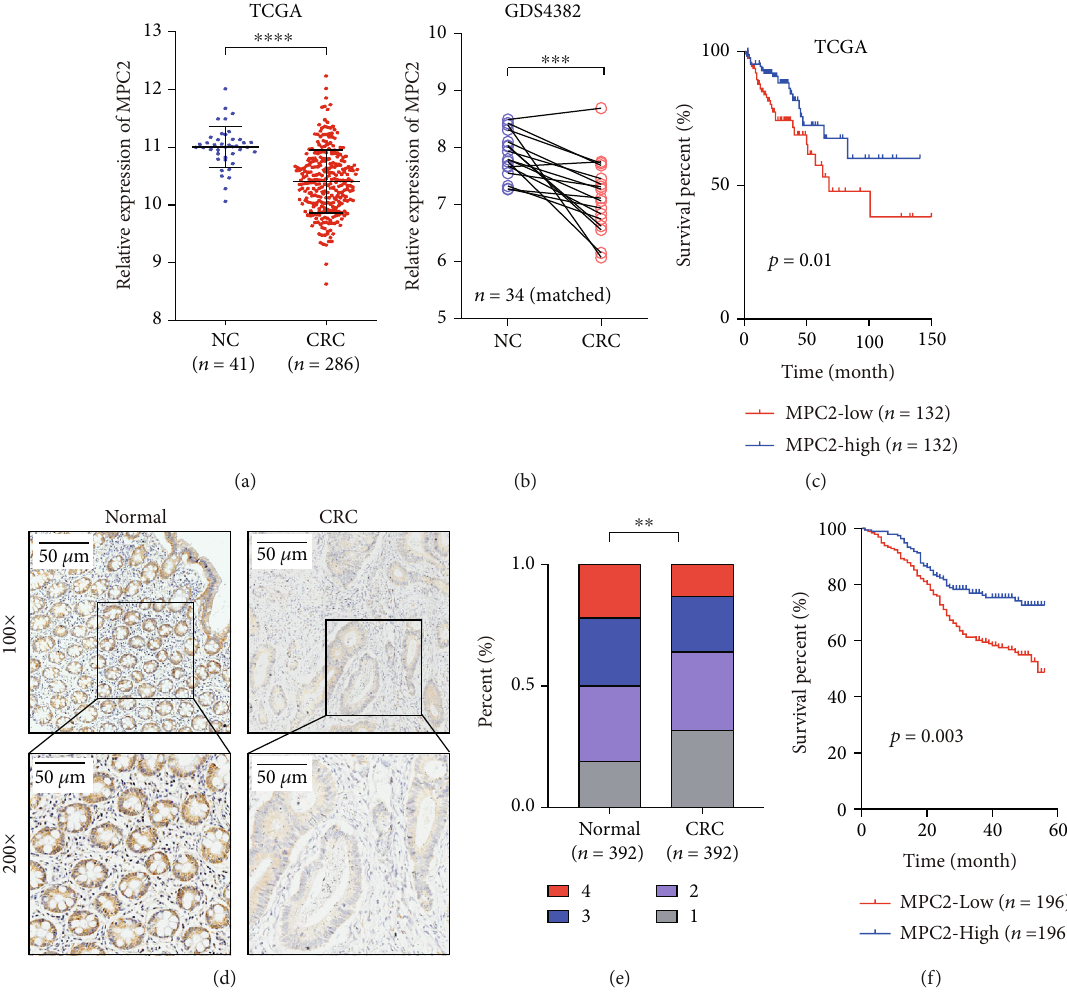
Figure 1: MPC2 is downregulated in tumor tissue and correlated with a poor prognosis of Colorectal Carcinoma (CRC). ( a) The mRNA expression of MPC2 in the CRC tissues compared to tissue adjacent to cancer in The Cancer Genome Atlas (TCGA) database. (b) The mRNA expression of MPC2 in the CRC tissues compared to paired tissue adjacent to cancer selected from the GDS4382 database. (c) Overall survival analyzed by a log-rank test and the Kaplan-Meier method according to the MPC2 mRNA expression from the TCGA dataset. (d) Representative IHC images for MPC2 expression of normal tissues and matched CRC tissues from TMA. (e) IHC score of MPC2 expression of normal tissues and matched CRC tissues from TMA. (f) Overall survival analyzed through the log-rank test and Kaplan-Meier method based on the MPC2 mRNA expression from TMA. ∗ p < 0 : 05 , ∗∗ p < 0 : 01 , ∗∗∗ p < 0 : 001 , and ∗∗∗∗ p < 0 : 0001